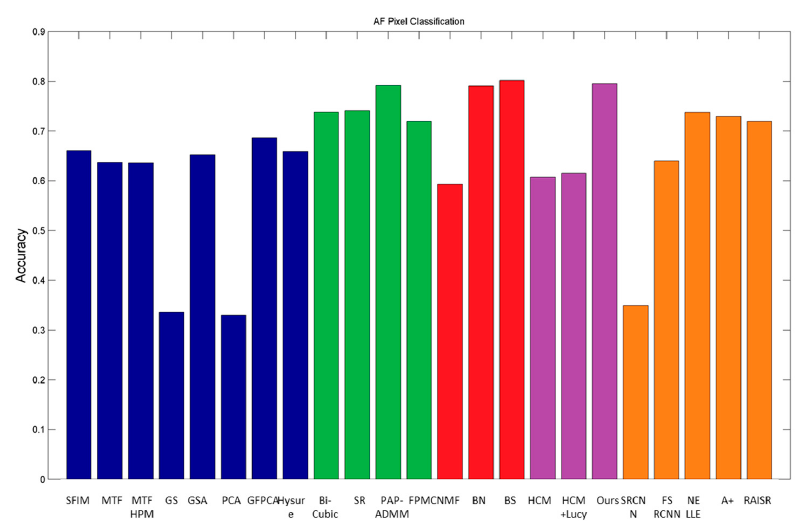
Figure 11. Spectral signatures of the eight cluster centers.